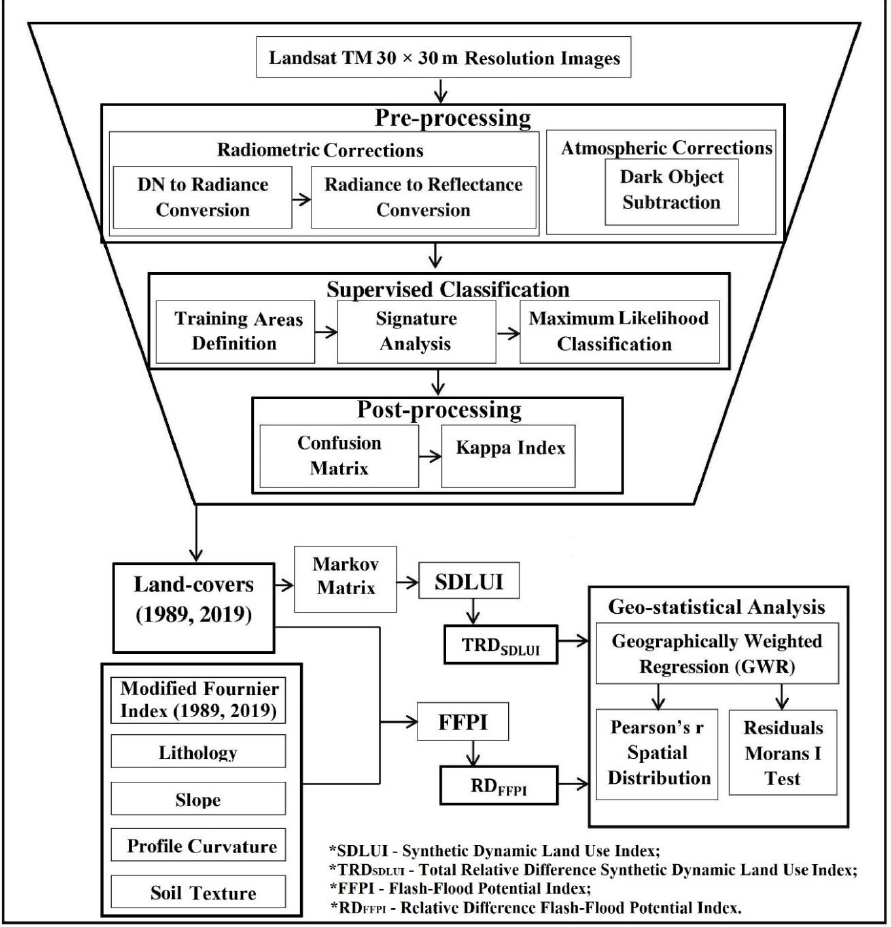
Figure 2. Methodology performed in the study.